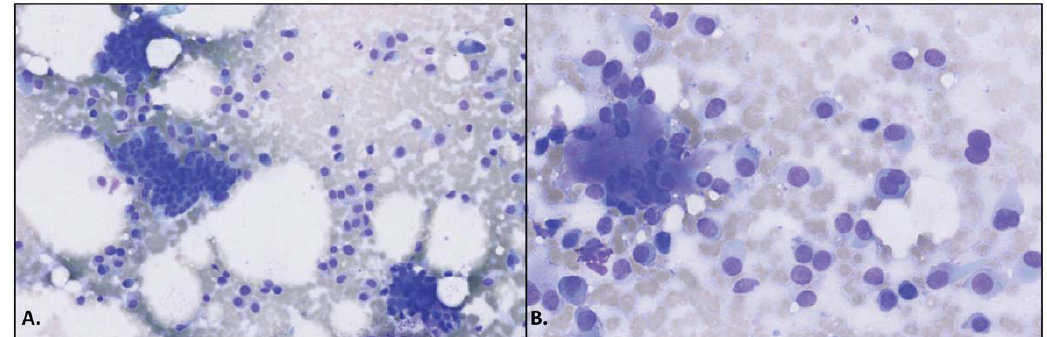
Figure 2- Patient with a pleomorphic adenoma with an epithelial cell component, a myoepithelial cell component, and